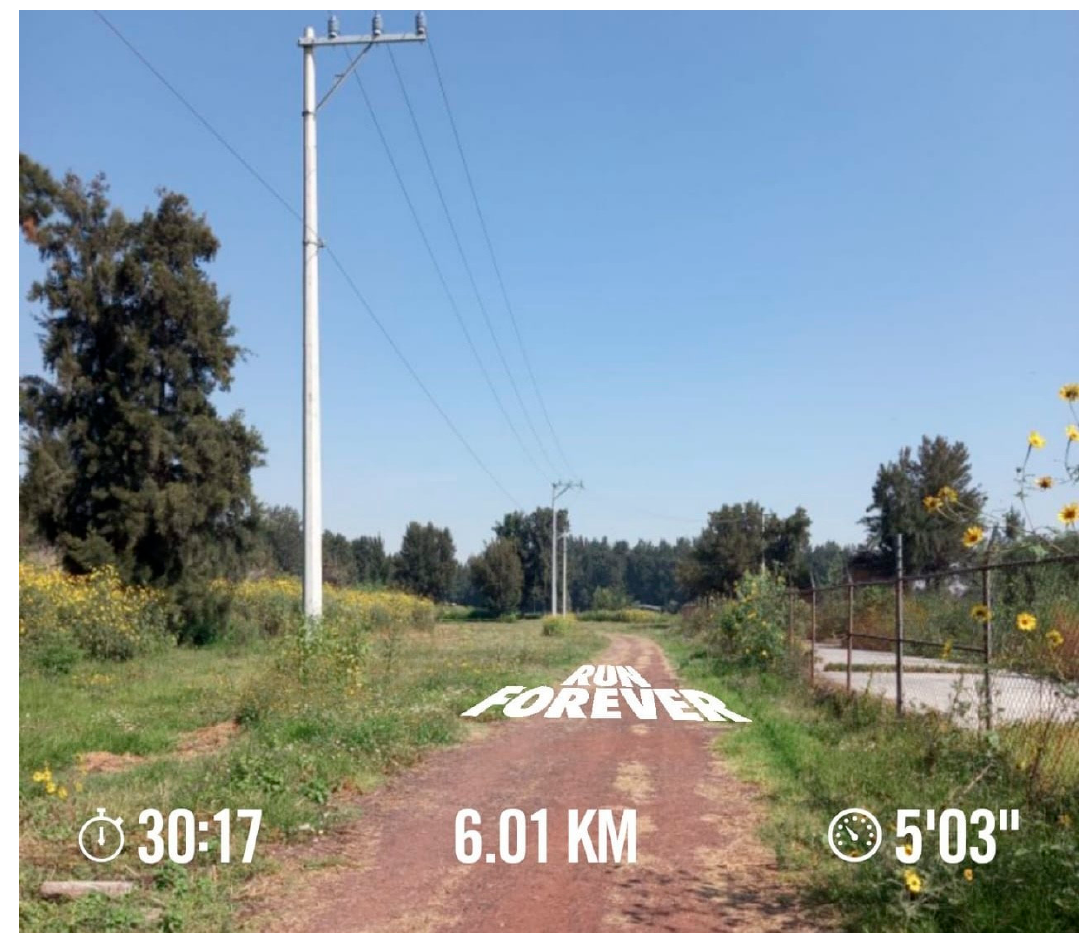
Figure 5 . Bosque de Tláhuac, UGS near Participant 2’s apartment